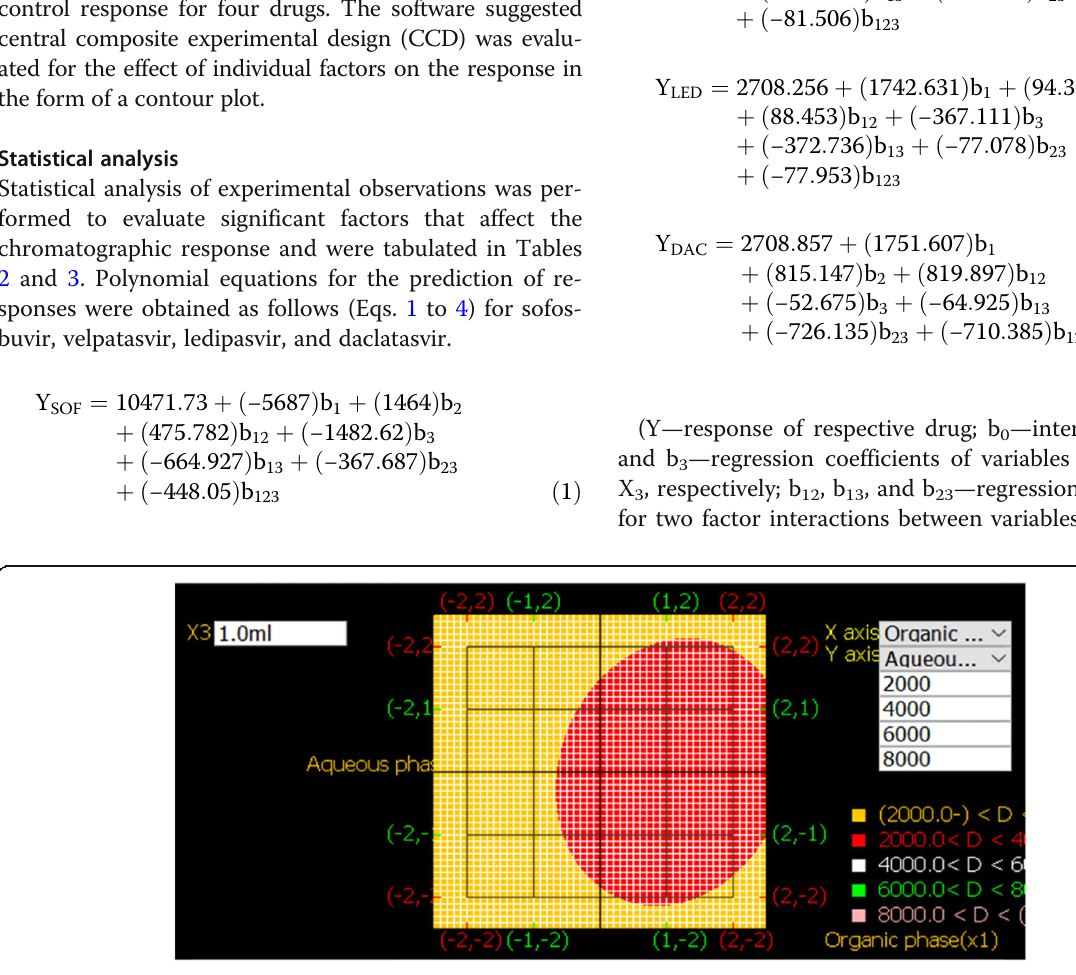
Fig. 3 Contour plot of ledipasvir at 1.0 ml flow